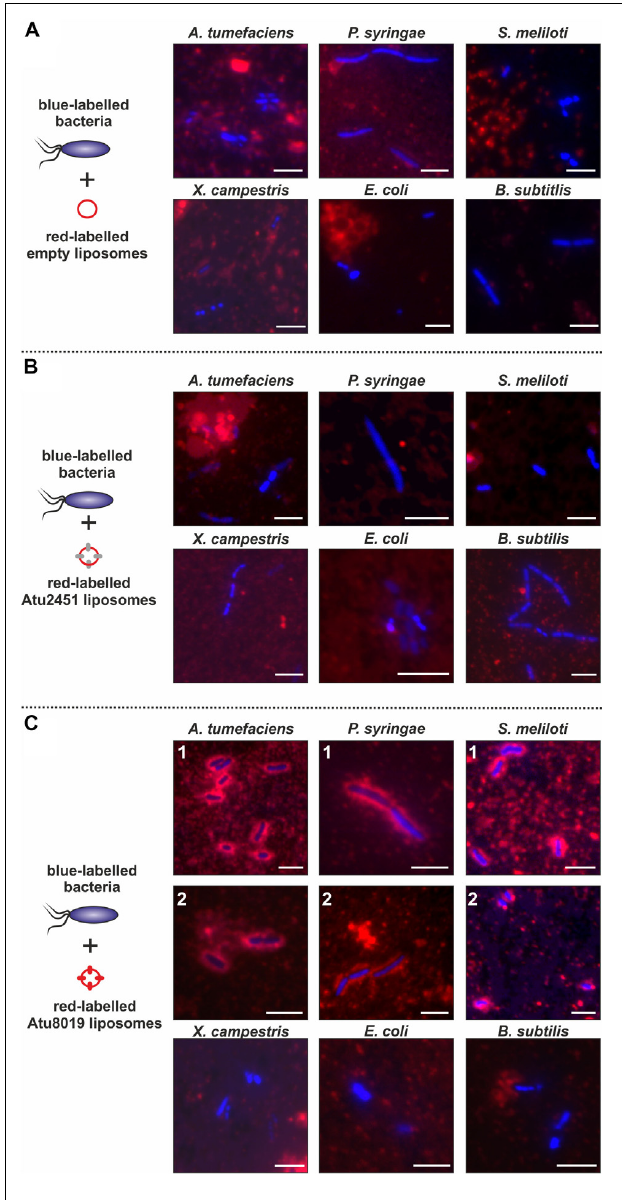
FIGURE 8 | Specific interaction of Atu8019 HIS proteoliposomes with P. syringae and S. meliloti . Interaction of empty liposomes (A) , Atu2451 proteoliposomes (B) and Atu8019 proteoliposomes (C) with target cells. DiI-labeled (proteo)liposomes and Hoechst33342-labeled target bacteria were incubated for 2 h before imaging by fluorescence microscopy. Scale bars: 5 µ